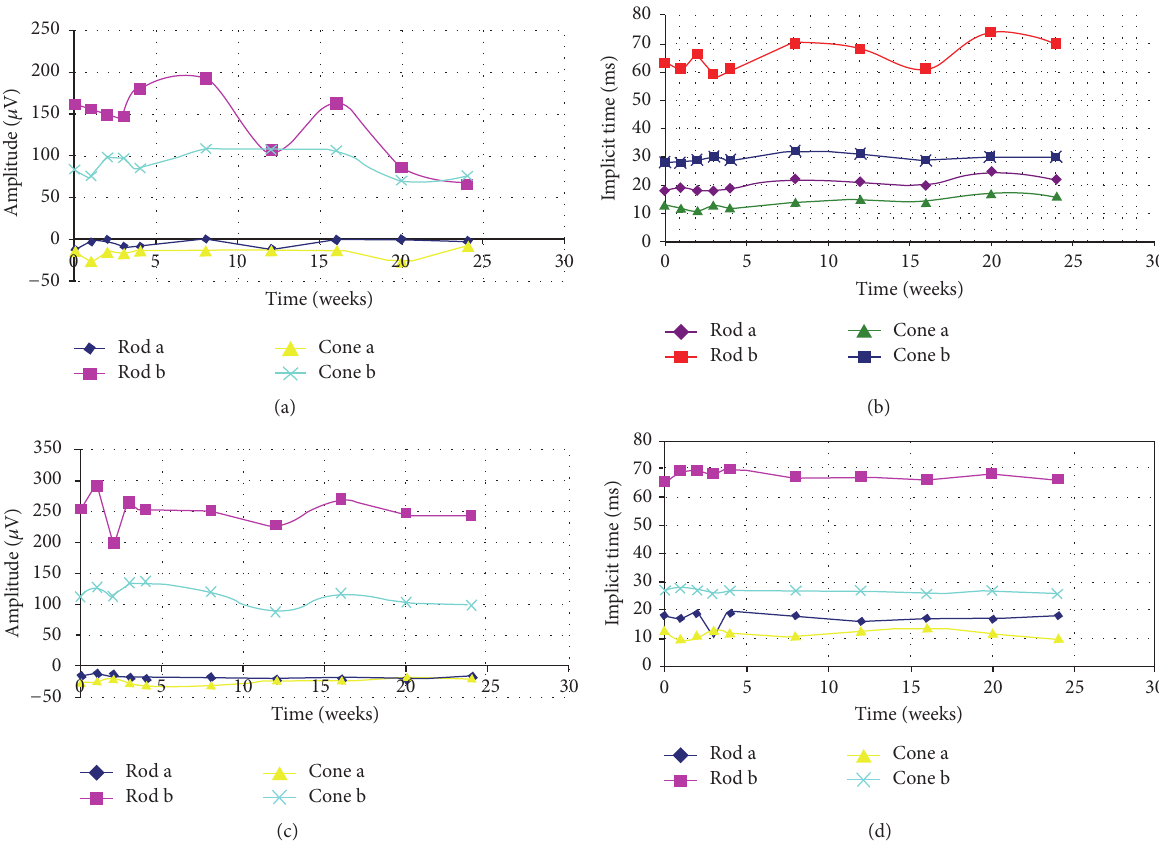
Figure 2: Mean b-wave amplitude response curves and implicit time responses at 6 months. (a and b) Eyes which underwent intravitreal injection of 0.1mL of pNIPAM demonstrate a slight depression of scotopic and photopic responses when compared to respective control fellow eyes (c and d). Comparisons of the preoperative b-wave ratios versus the ratios at each time exam revealed no significant differences ( 𝑃 < 0.5 ) when calculated with the Student 𝑡 -test.